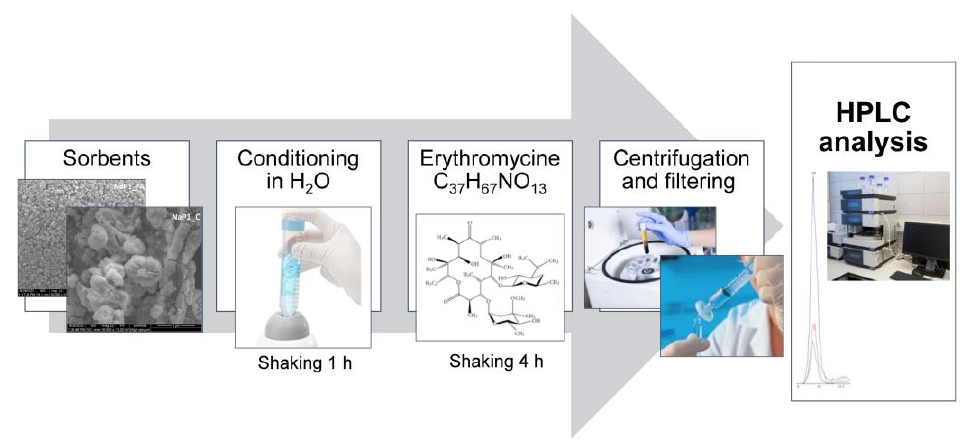
Figure 10. Research methodology flow chart.